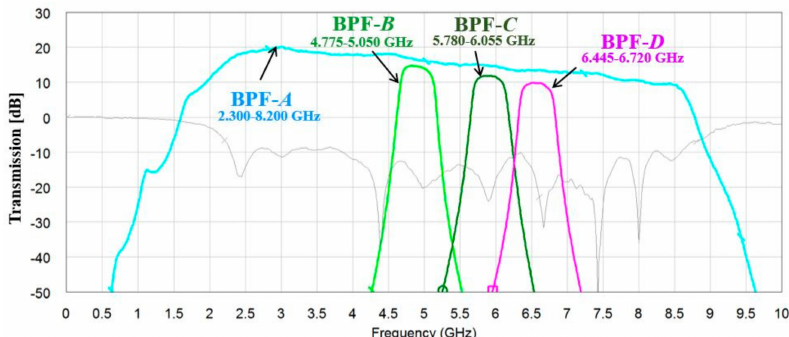
Figure 9. Electromagnetic simulations of the | S21 | transmissions of one WS RF / IF board receiver chain from SMA board input to mixer (includes the RF low noise amplifier (LNA), band pass filter (BPF) and mixer conversion loss) by selecting the four BPFs.